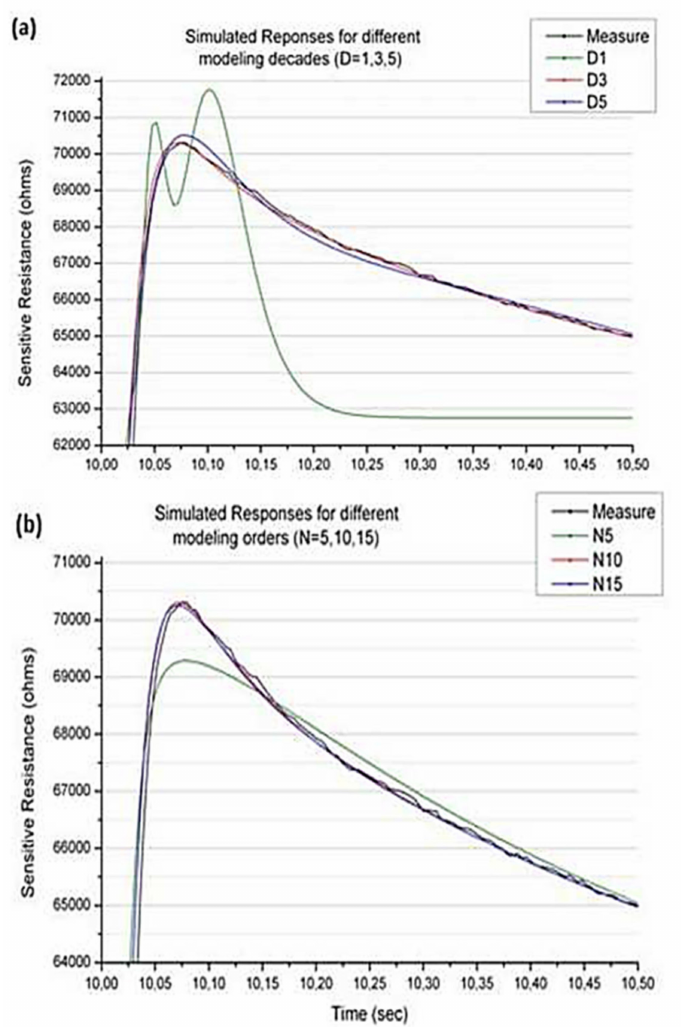
Figure 9. Simulated responses for different modeling decades ( a ) and different modeling orders ( b